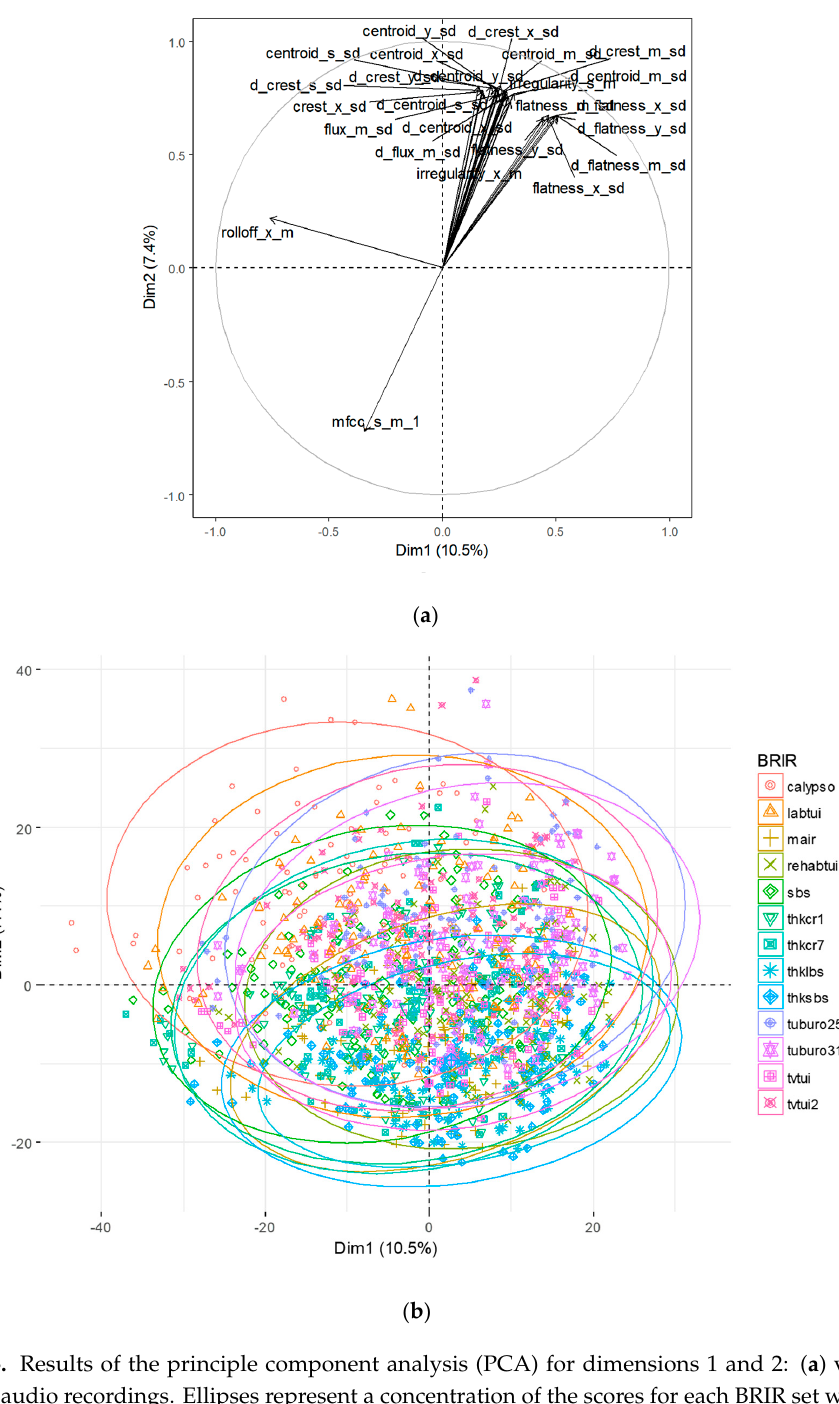
Figure 5. Results of the principle component analysis (PCA) for dimensions 1 and 2: ( a ) variable plot; ( b ) audio recordings. Ellipses represent a concentration of the scores for each BRIR set with 95% confidence boundaries around group means.